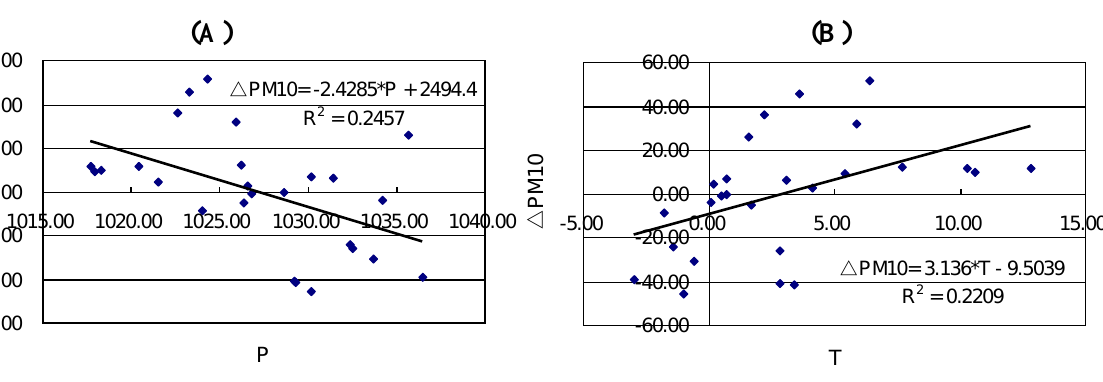
Figure 5. Scatterplots of residuals in predicting PM against the two most important variables. (A) air pressure; (B) air